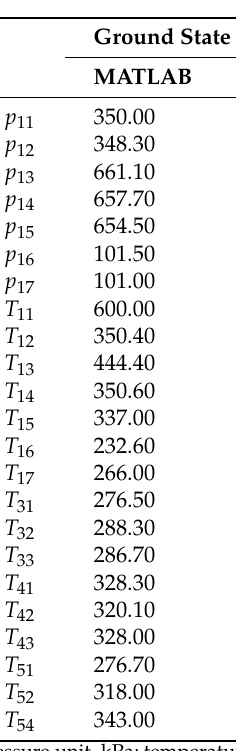
Table 2. Results of parameter matching.